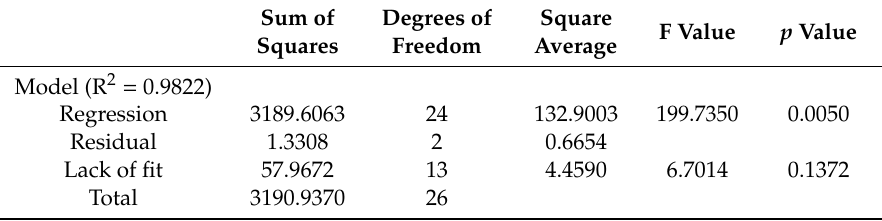
Table 6. Variance analysis of the adjusted model made with sulfuric acid. Sum of Degrees of Square F Value p Value Squares Freedom Average Model (R 2 = 0.9929) Regression 4572.0612 24 190.5026 215.6589 0.0046 Residual 1.7667 30.9270 R 2 : Coe ffi cient of determination. Table 7. Variance analysis of the adjusted model made with phosphoric acid. Sum of Degrees of Square F Value p Value Squares Freedom Average Model (R 2 = 0.9822) Regression 3189.6063 24 132.9003 199.7350 0.0050 Residual 1.3308 2 0.6654 Lack of fit 57.9672 13 4.4590 6.7014 0.1372 Total 3190.9370 26 R 2 : Coe ffi cient of